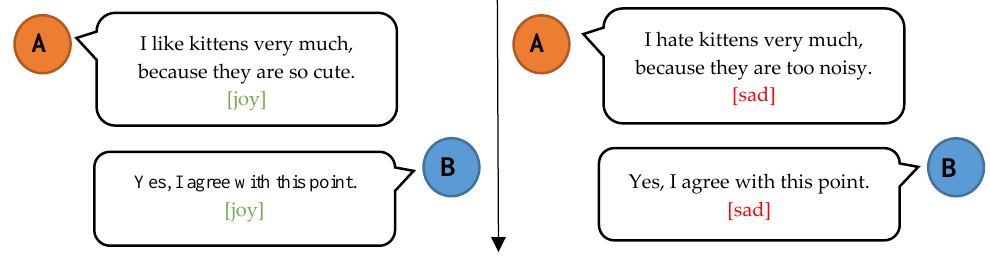
Figure 1. The utterance “Yes, I agree with this point.” can deliver different emotions in different contexts.